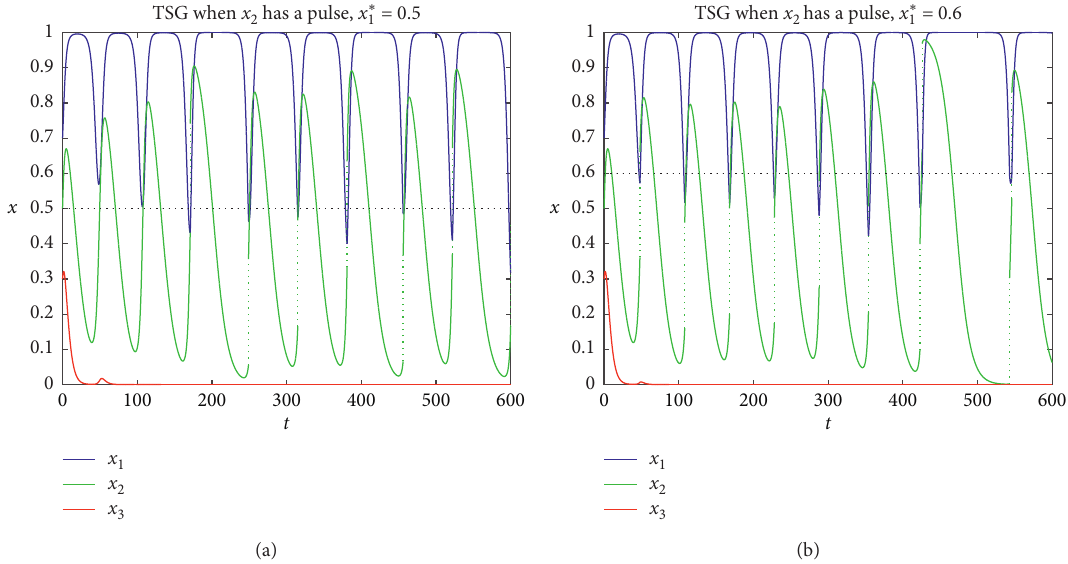
Figure 4: TSGs of DIDEs (2) when x